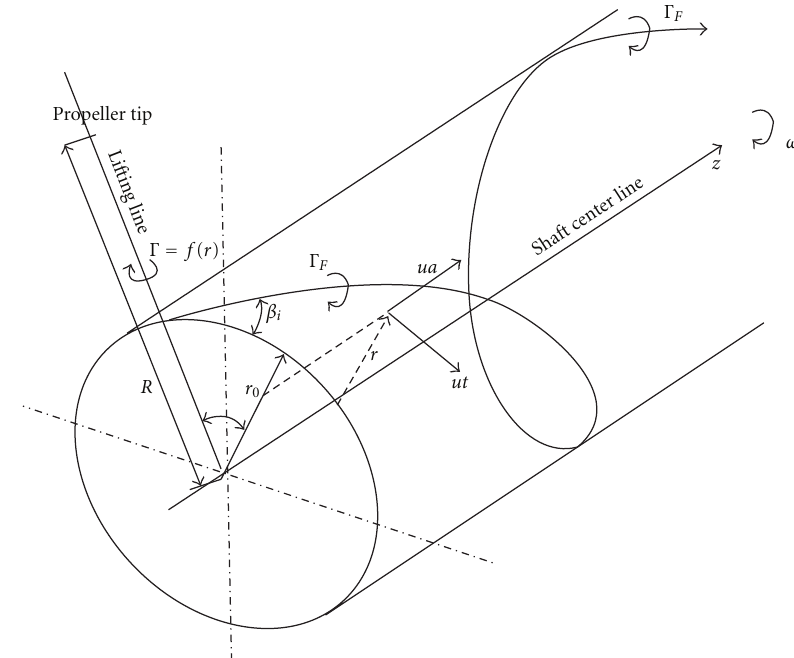
Figure 5: Reference systems used for the lifting line numerical model.